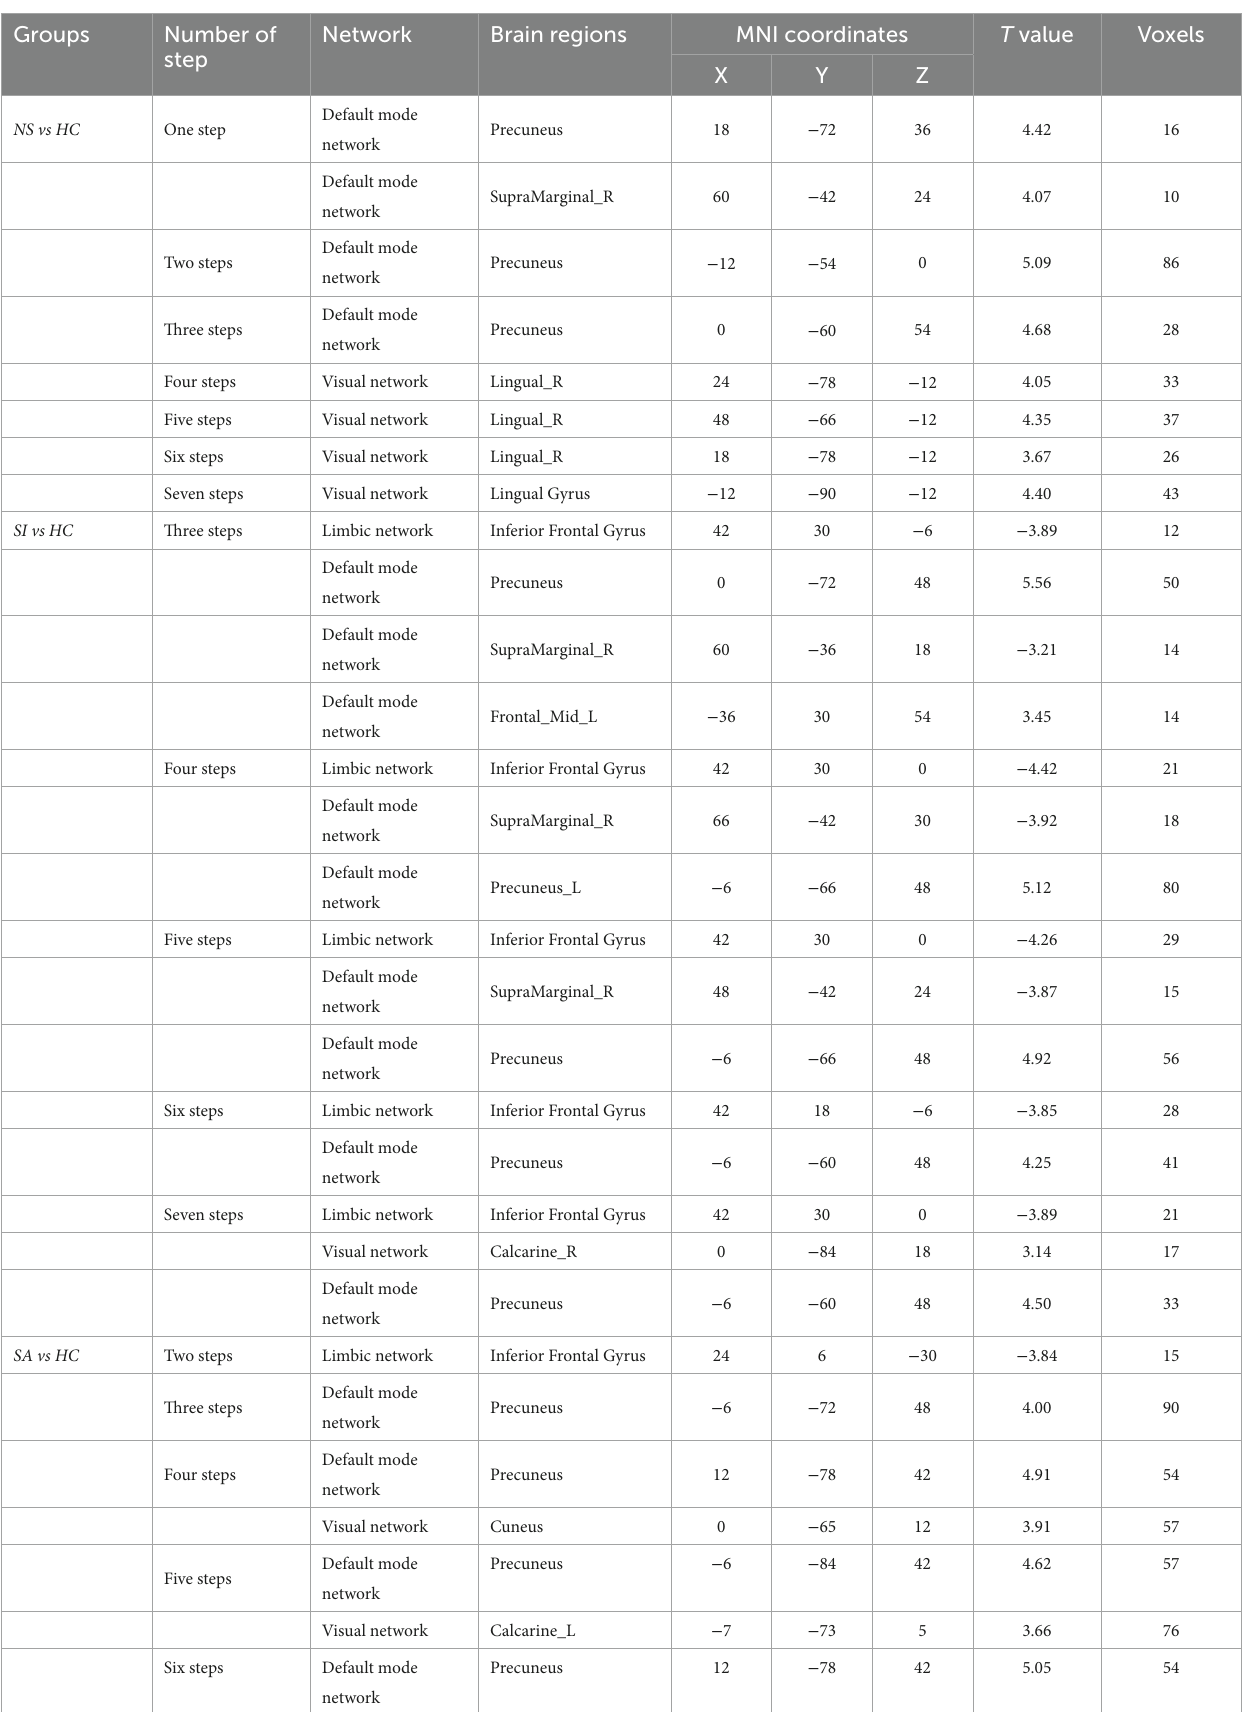
TABLE 3 Group differences in degree of stepwise functional connectivity.